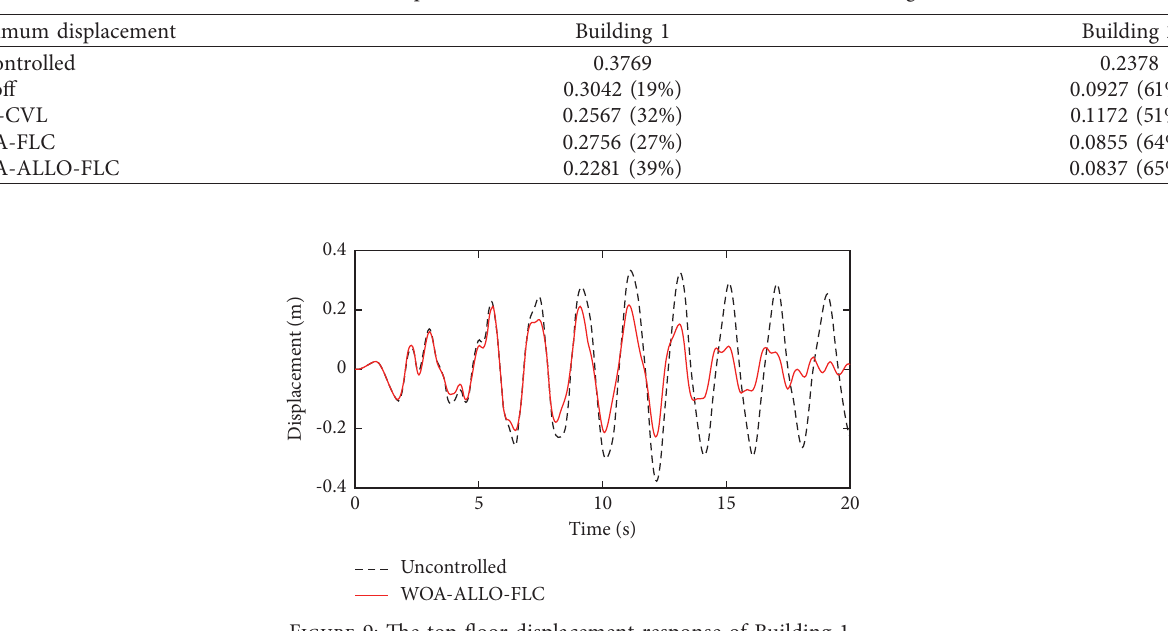
Table 8: Maximum responses (reduction ratios) with different control strategies.